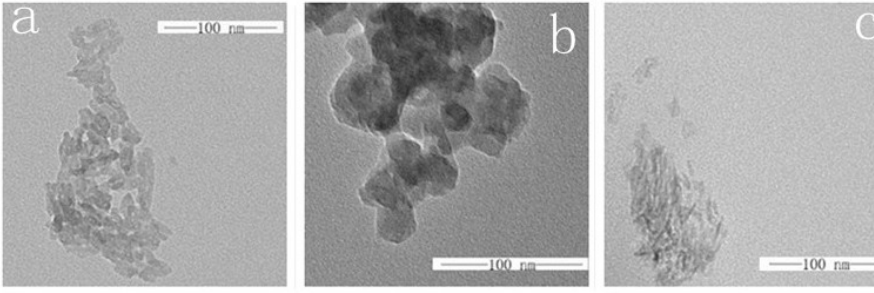
Figure 3. TEM images of ( a ) HAP, ( b ) HAP-NH